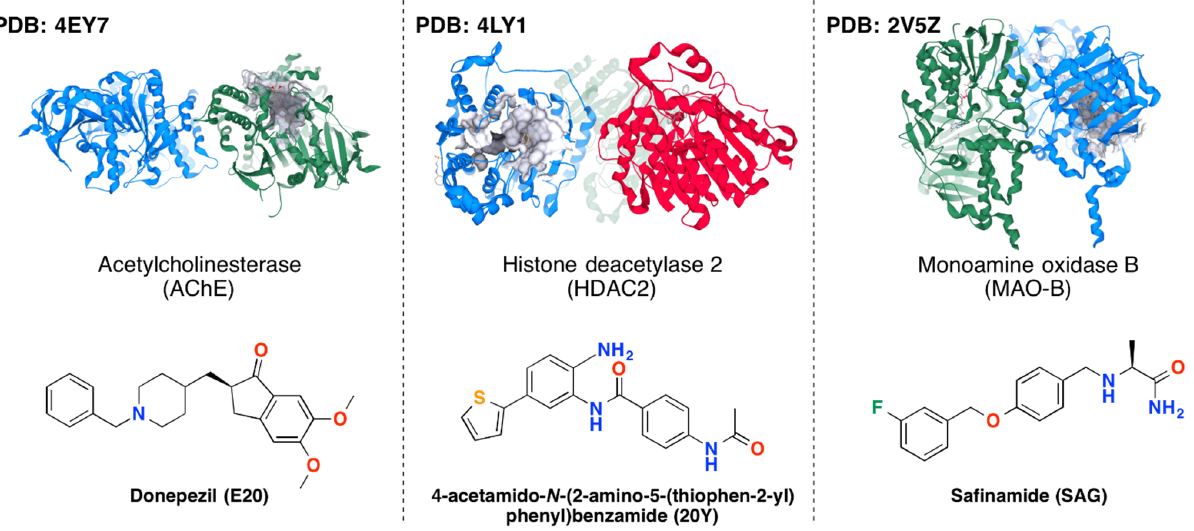
Figure 1. PDB crystallographic structures and reference ligands of the selected target protein complexes.